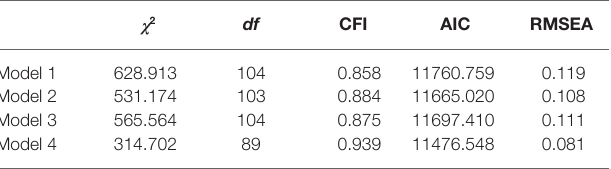
TABLE 2 | Goodness-of-fit of alternative models for the Prosociality Scale (Study 1).